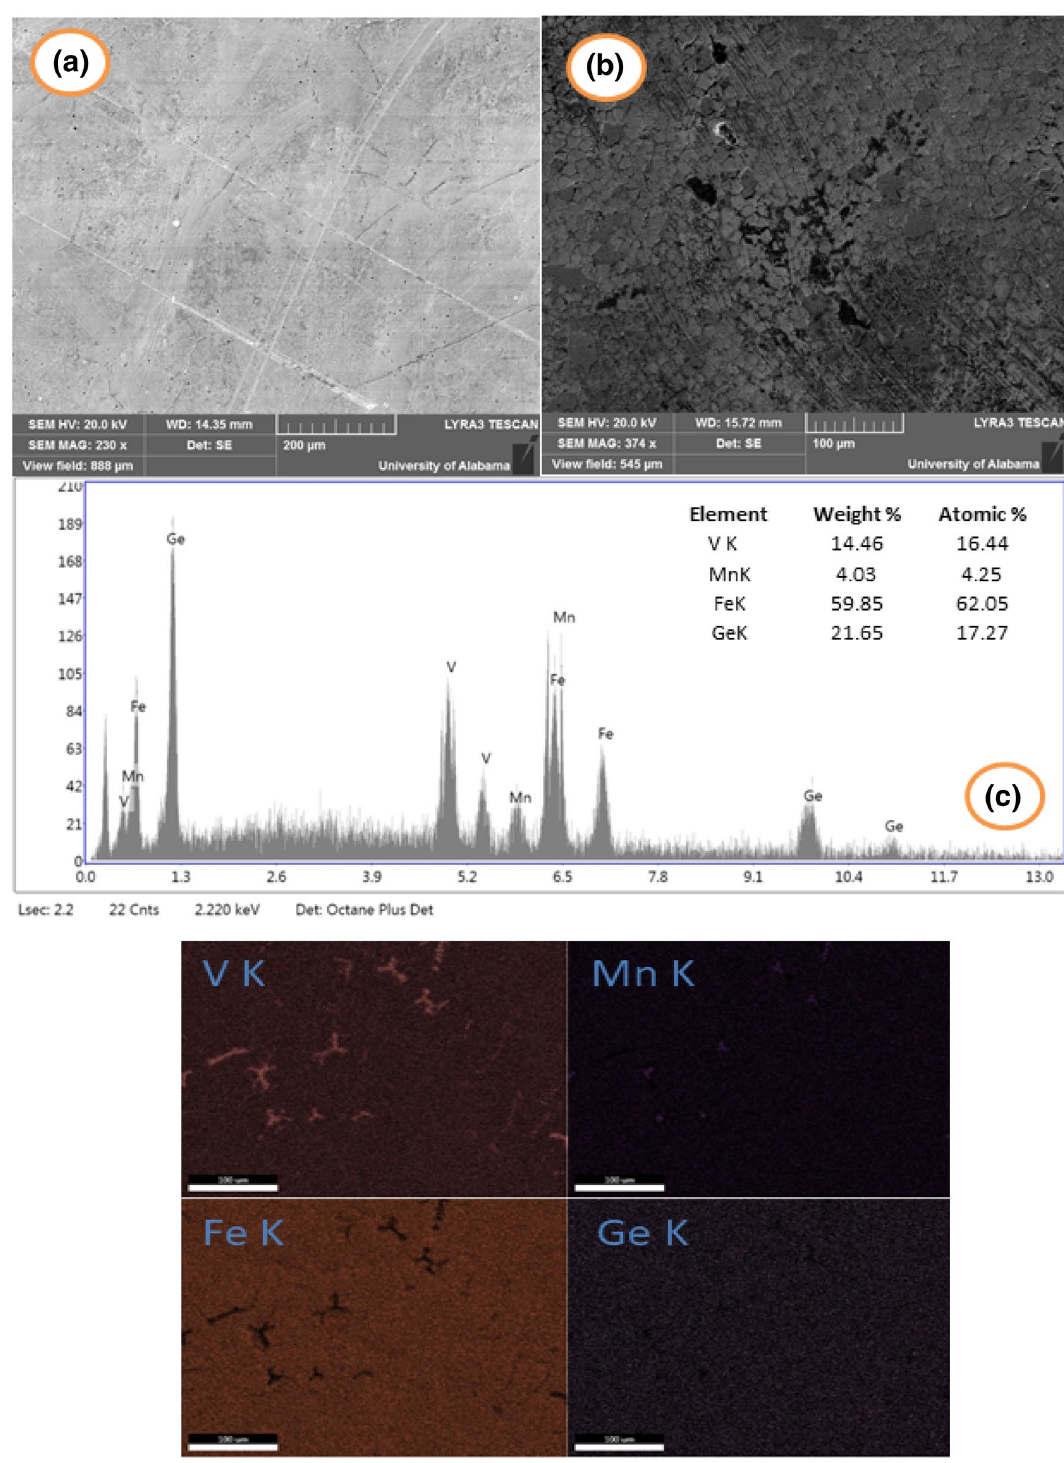
Fig. 4 SEM images in 200 and 100 μm frames in ( a ) and ( b ) and EDX micrograph with an atomic ratio in ( c ) and colored SEM images of V, Mn, Fe, and K elements for